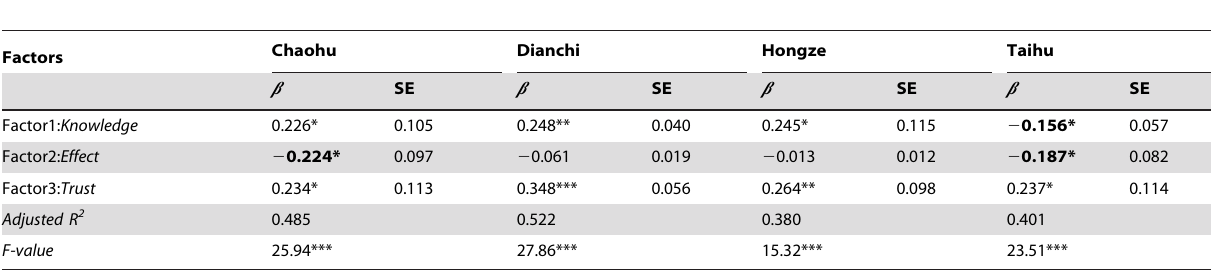
Table 8. Using Factor Scores about HABs to Explain Mean Risk Tolerance of Four Lakes.